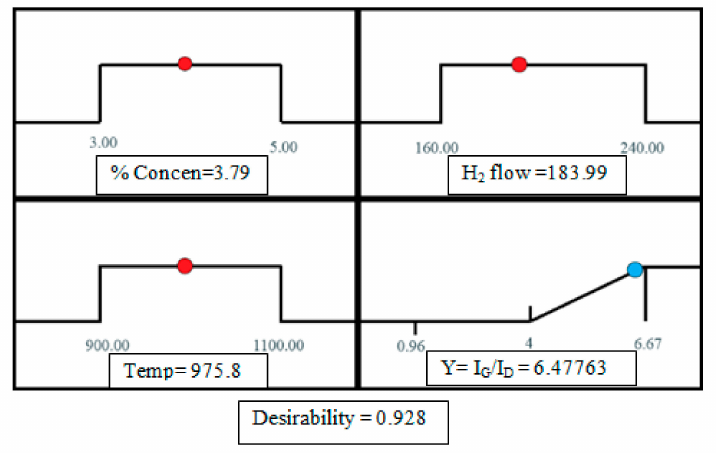
Figure 9. Desirability ramp for numerical optimization of three independent variables (catalyst concentration ratio, hydrogen flow rate, reaction temperature) and response surface (CNT